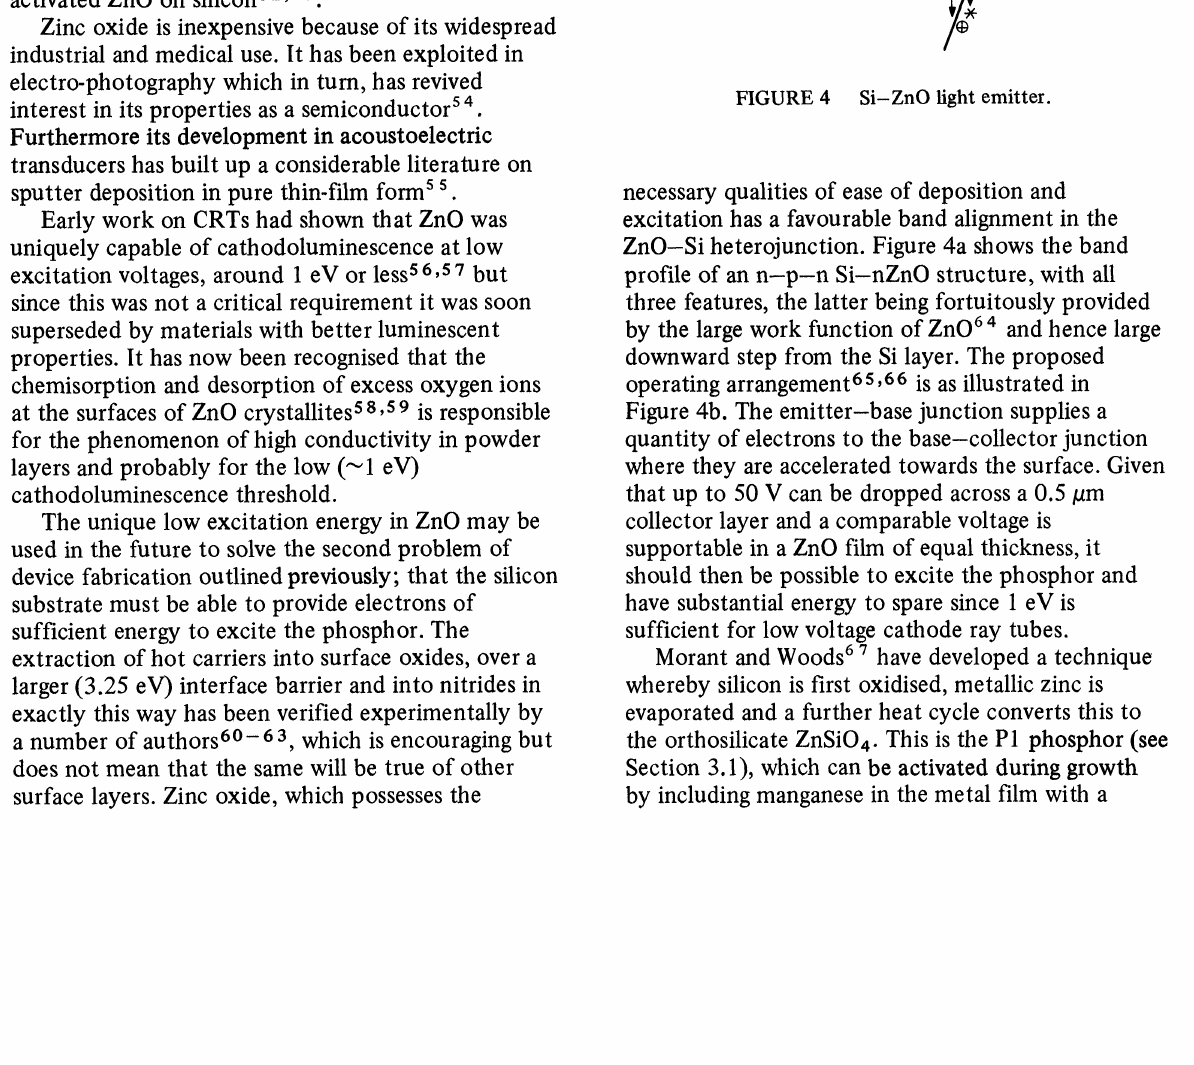
FIGURE 4 Si-ZnO light